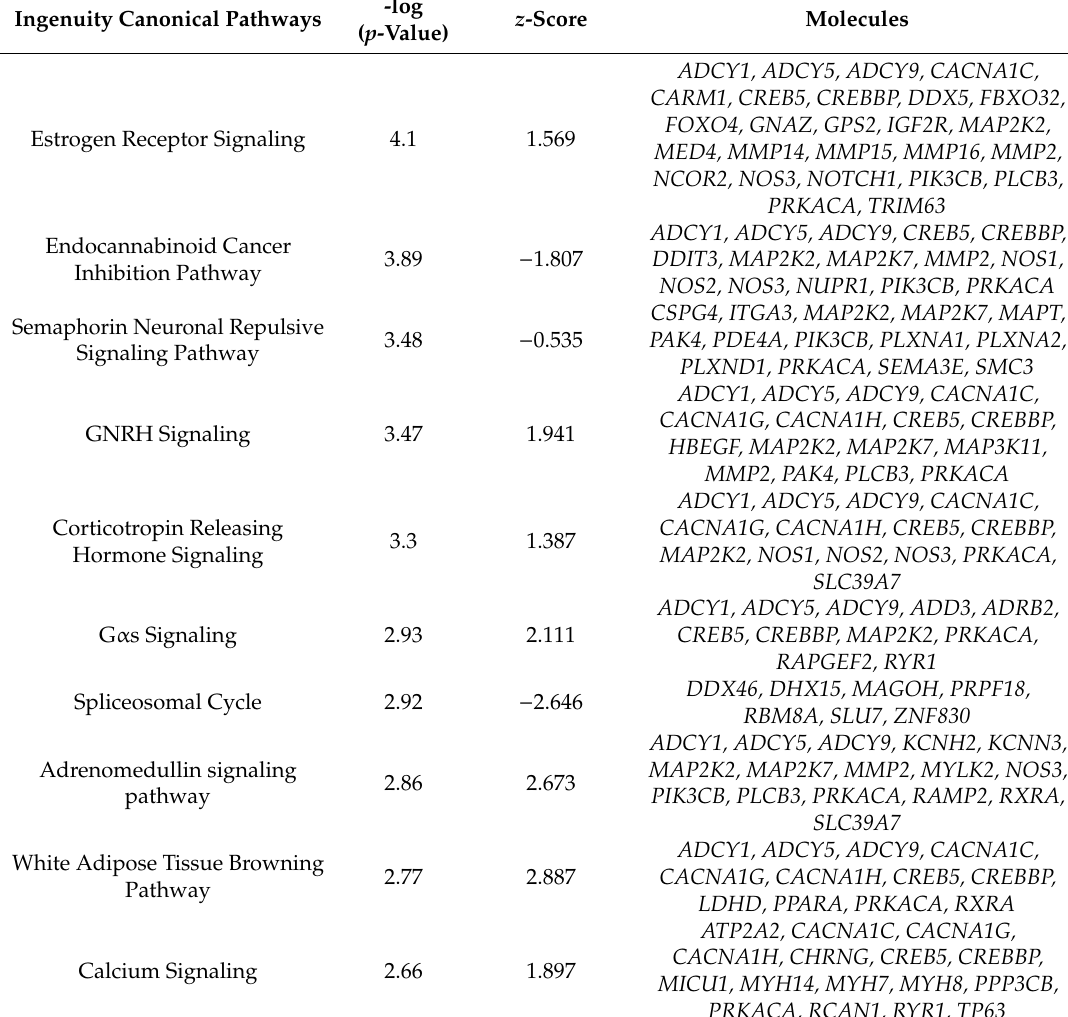
Table 1. Top 10 canonical pathway in IPA analysis of group A vs. group